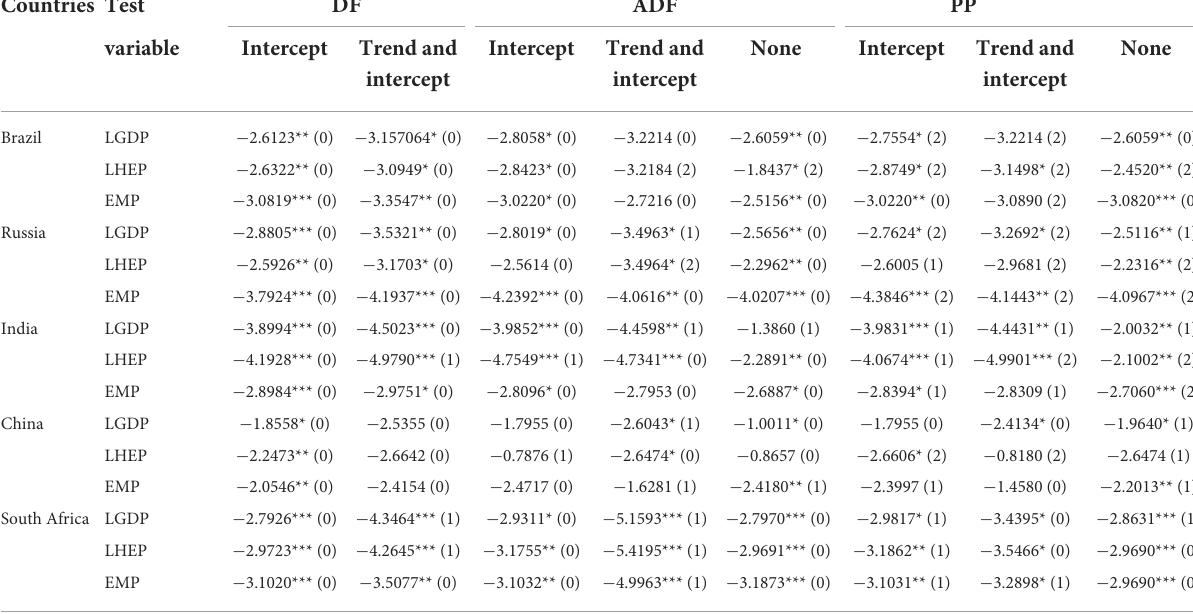
TABLE 4 Unit root test (1 st difference